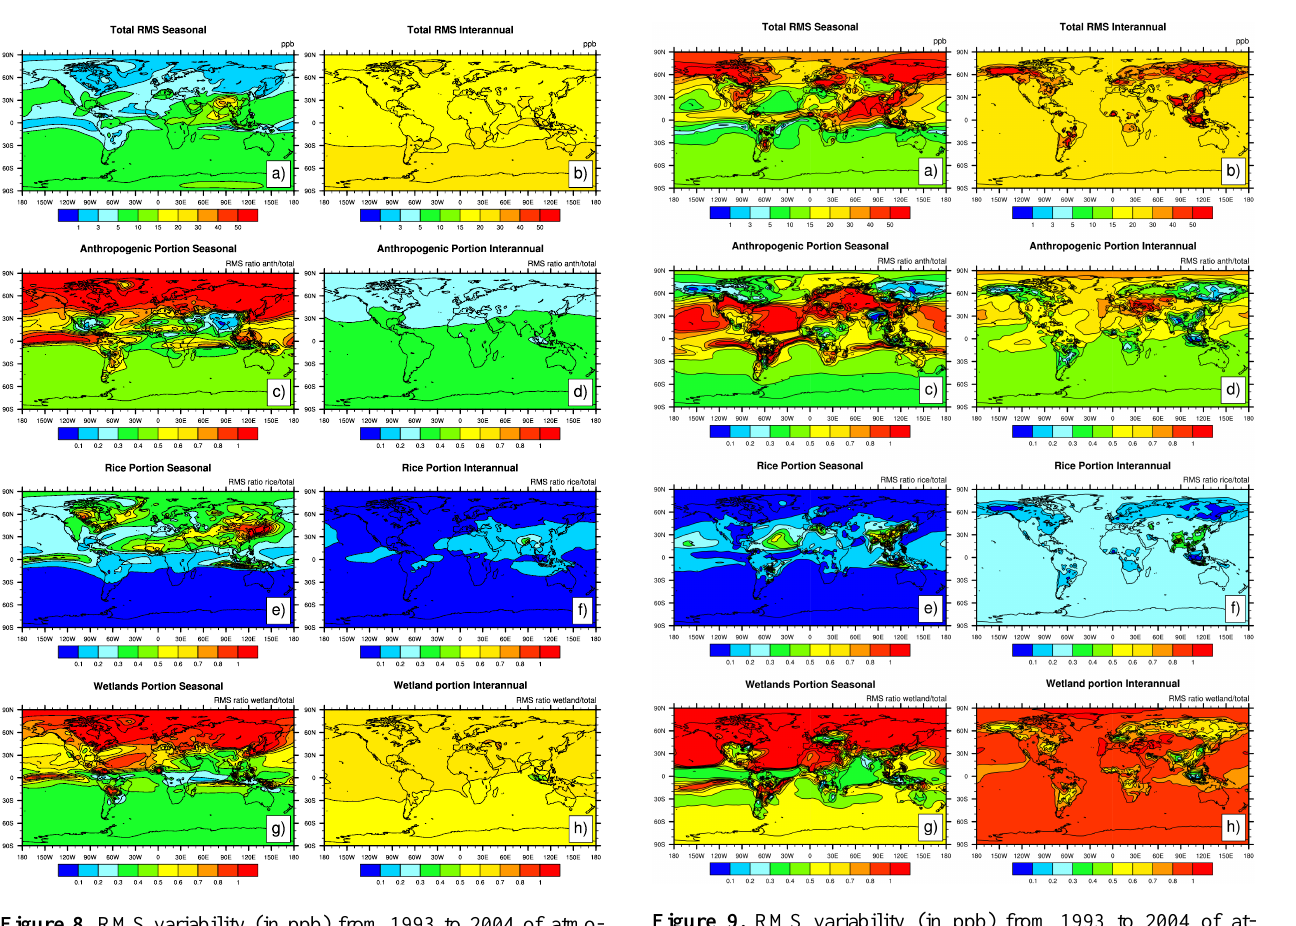
Figure 8. RMS variability (in ppb) from 1993 to 2004 of atmo- spheric CH 4 concentration in CN_a experiment. The left panel shows seasonal RMS variability and the right panel indicates inter- annual RMS variability. From the top to the bottom are total RMS variability (a, b) , anthropogenic contribution to total RMS variabil- ity (c, d) , rice contribution to total RMS variability (e, f) , and wet- land contribution to RMS variability (g, h) . Note that proportional RMS variability of anthropogenic sources, rice paddies, and wet- lands add up to >1 when cancellation among component tracers occurs in the summing of total CH 4 .